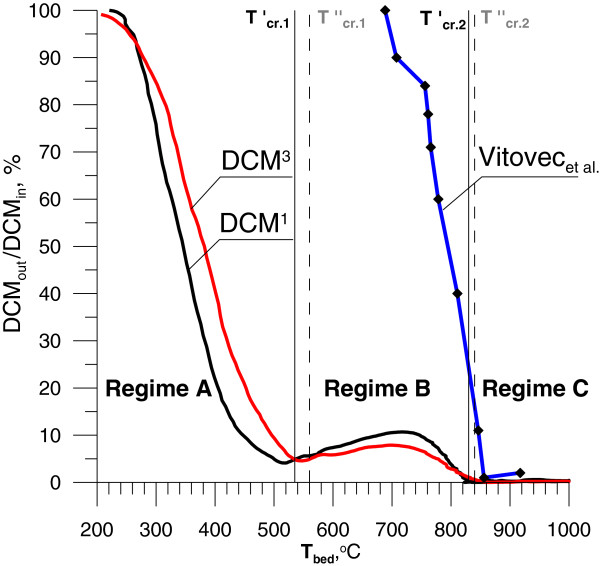
Degree of decomposition of CH2Cl2 for different temperature (DCMin and DCMout are the inlet and outlet concentration of dichloromethane respectively).